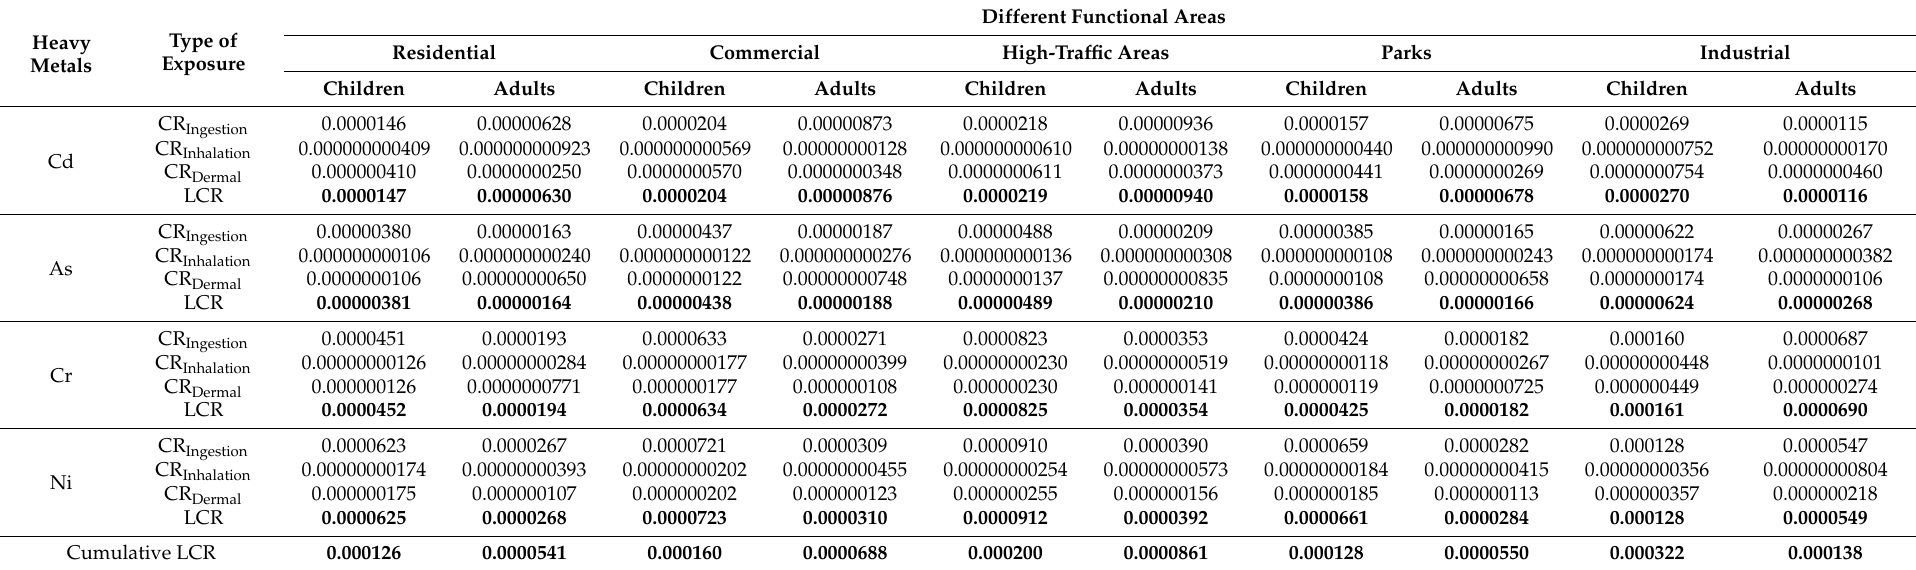
Table 9. Carcinogenic risk of HMs in road dust for five different functional